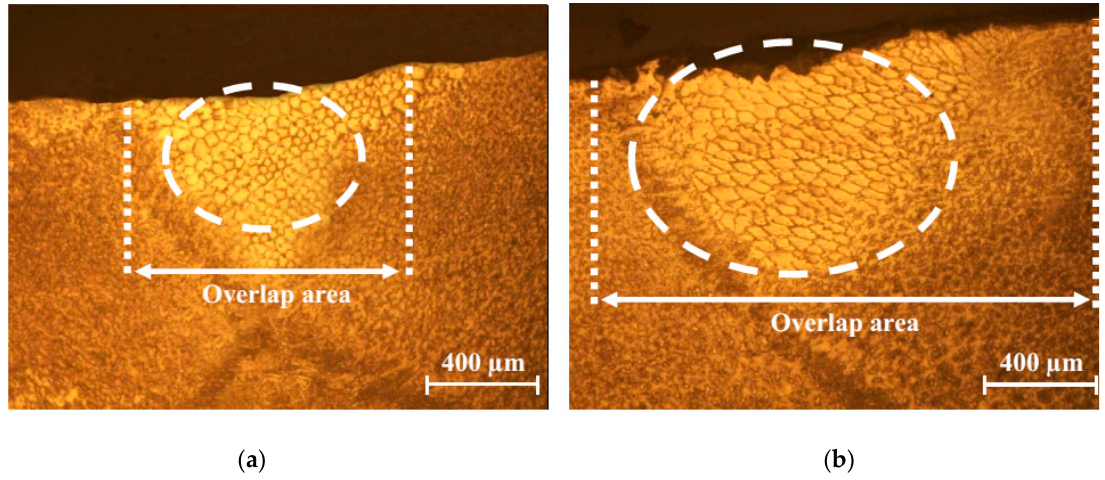
Figure 10. Optical micrographs of the overlap areas of the samples obtained at D b = 1.3 and hatch spacings of ( a ) 1.0 mm and ( b ) 0.50 mm, which show the back-transformed grains (within the dashed ovals).